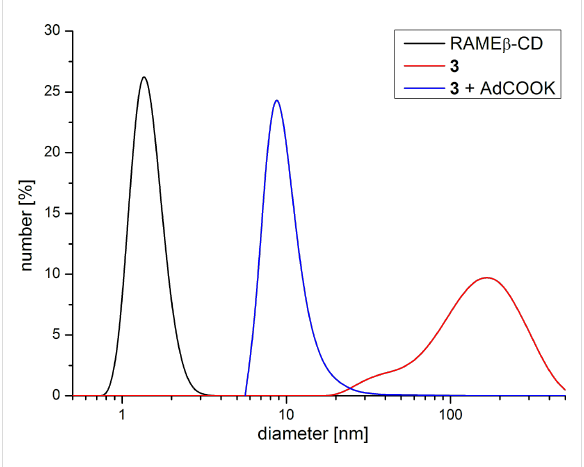
the HOMO–LUMO gap [14,15].